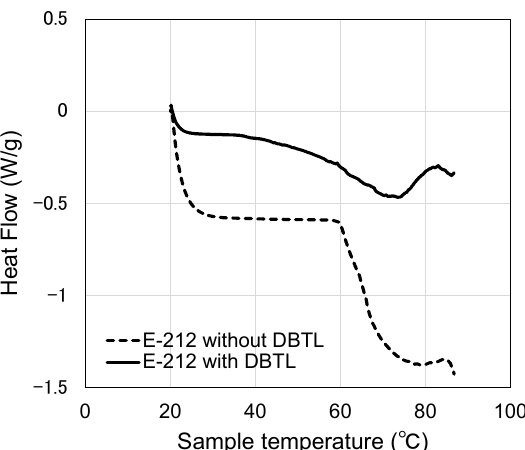
Figure 14. Differential scanning calorimetry (DSC) profile of the E-212 solution with or without DBTL.